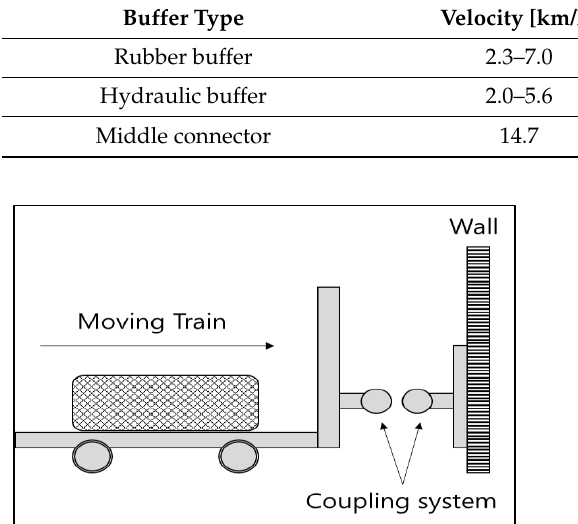
Figure 10. Schematic configuration of the collision tests.